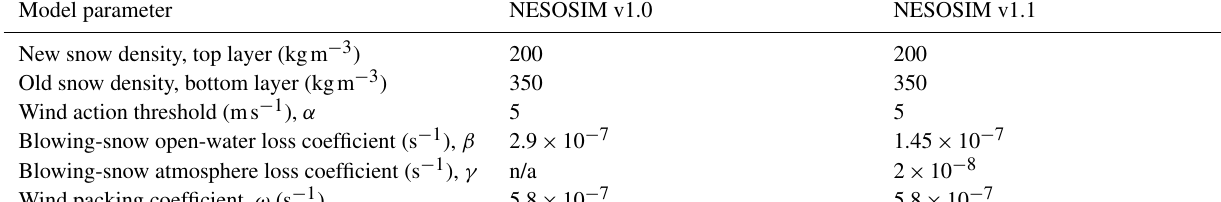
Table 1. Model configurations for NESOSIM v1.0 and v1.1. n/a: not applicable. Model